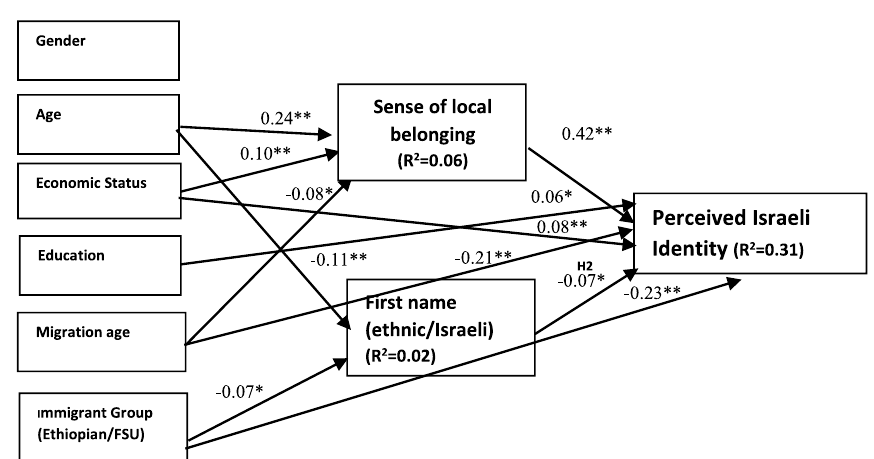
Fig. 2 Predicting perceived Israeli identity by sense of local belonging and first name- Graphic results from the SEM model (trimmed